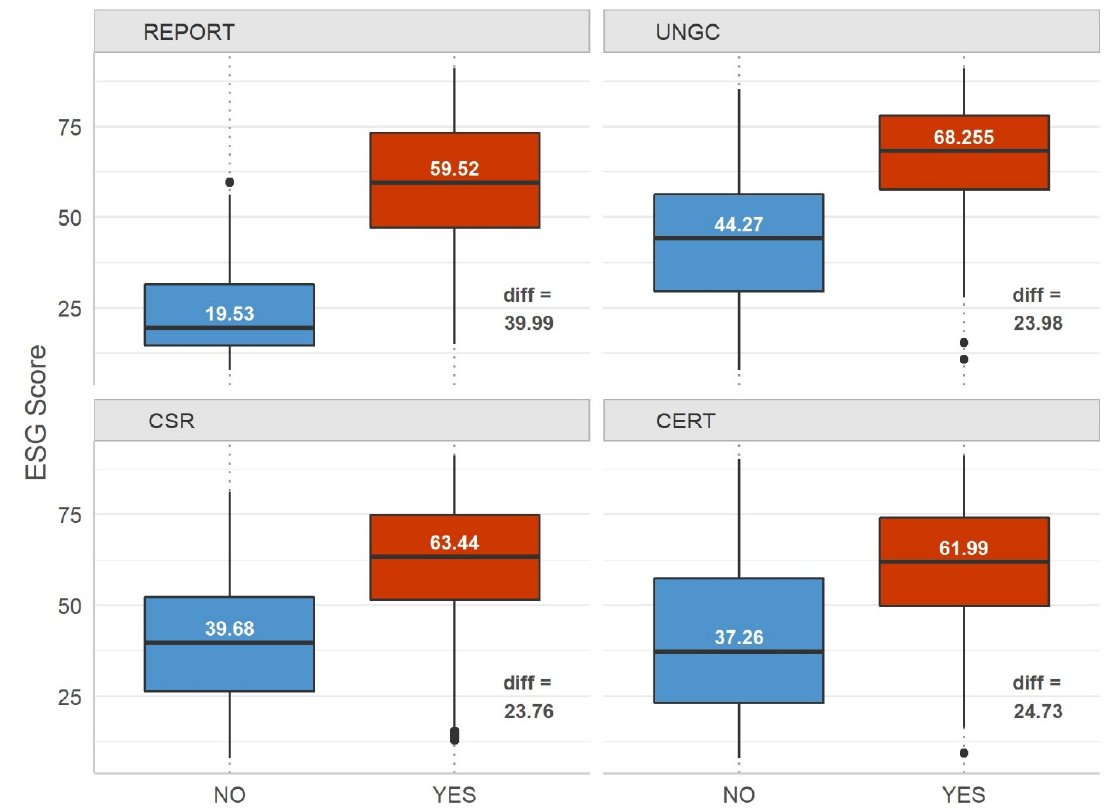
Figure 3. Differences in medians of ESG_SC between the firm-year observations with sustainability policy attributes (REPORT, UNGC, CSR, CERT).